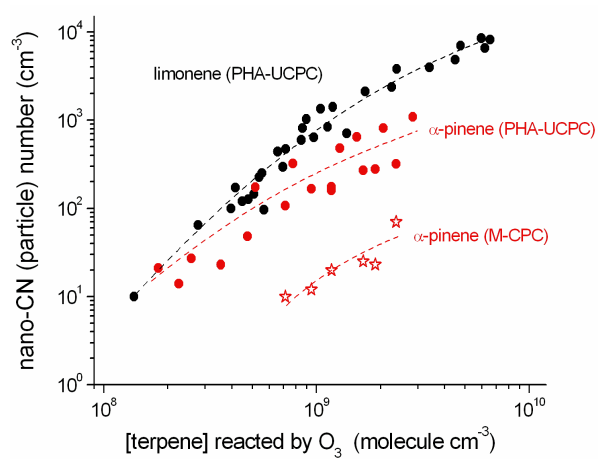
Fig. 1. Measured particle numbers (PHA-UCPC and M-CPC) as a function of converted terpene by the ozone reaction. The H 2 SO 4 concentrations were below 10 6 moleculecm − 3 . The reactant con- centrations are given in Table 1, measurement series 9 and